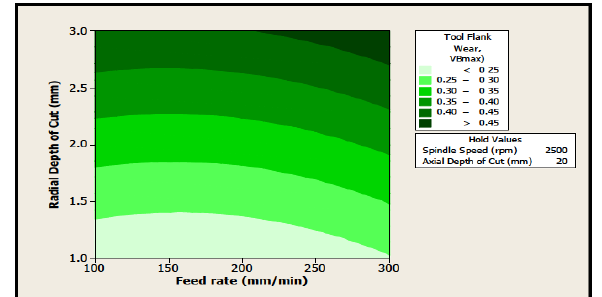
Figure 7: Contour plot of tool wear vs. radial depth of cut and feed rate.